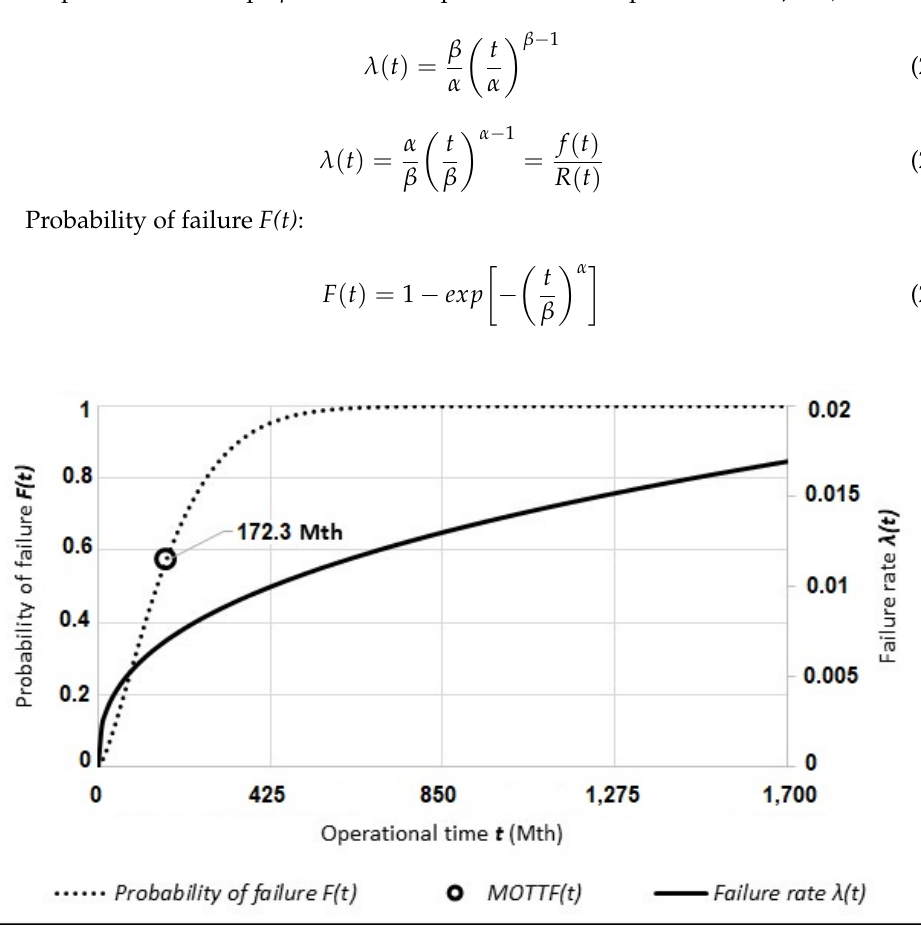
Figure 2 Failure rate λ (t) for the forwarder f810D-829. Figure 2. Failure rate λ (t) for the forwarder